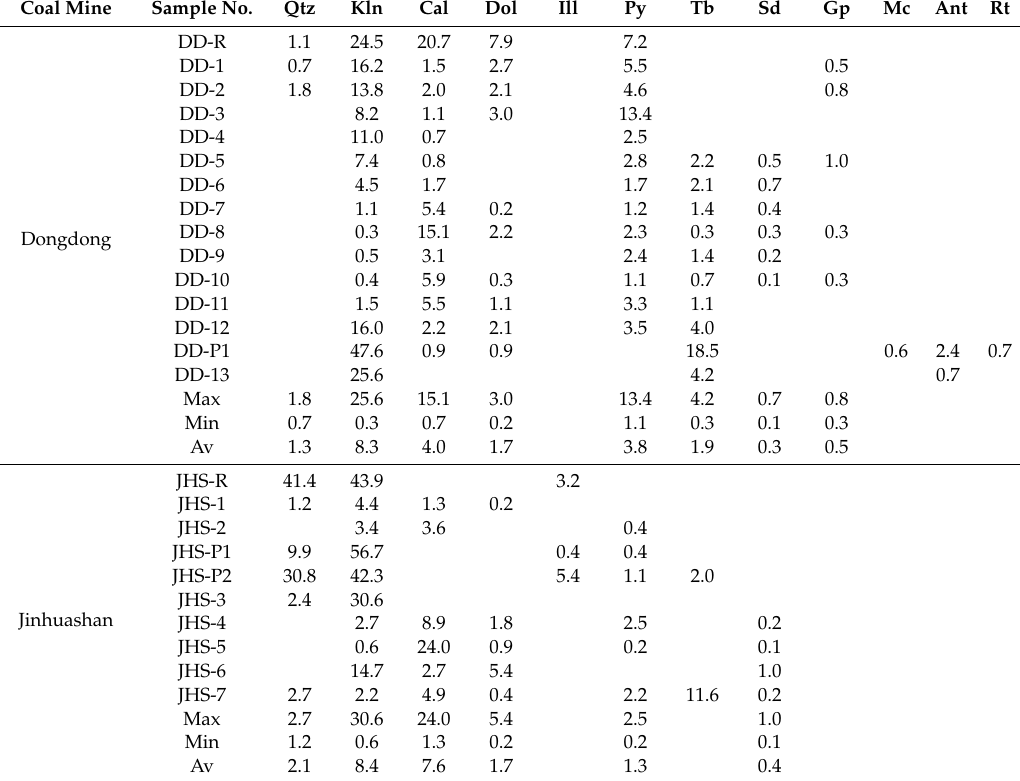
Table A2. Thesemi-quantitativecontentsofmainmineralphasesinthestudiedcoals(%, onwhole-coalbasis). Coal Mine Sample No.